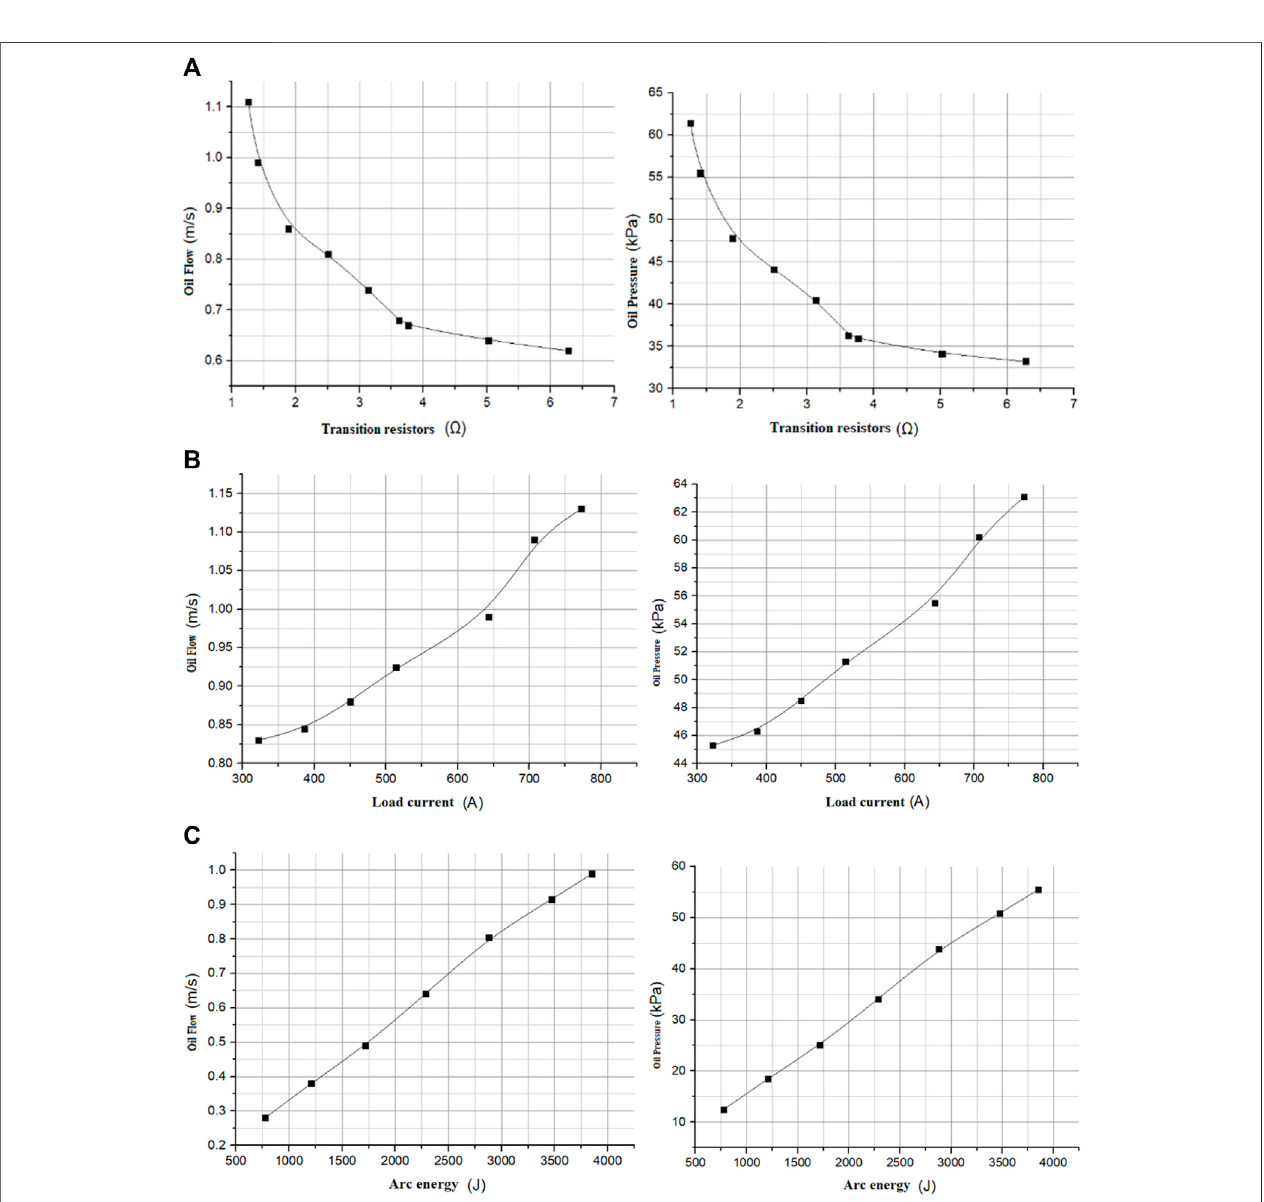
FIGURE 11 | Variation curve of oil fl ow and oil pressure with transition resistance, load and total arc energy. (A) Variation curve of oil fl ow and oil pressure with transition resistance. (B) Variation curve of oil fl ow and oil pressure with load. (C) Variation curve of oil fl ow and oil pressure with total arc energy.